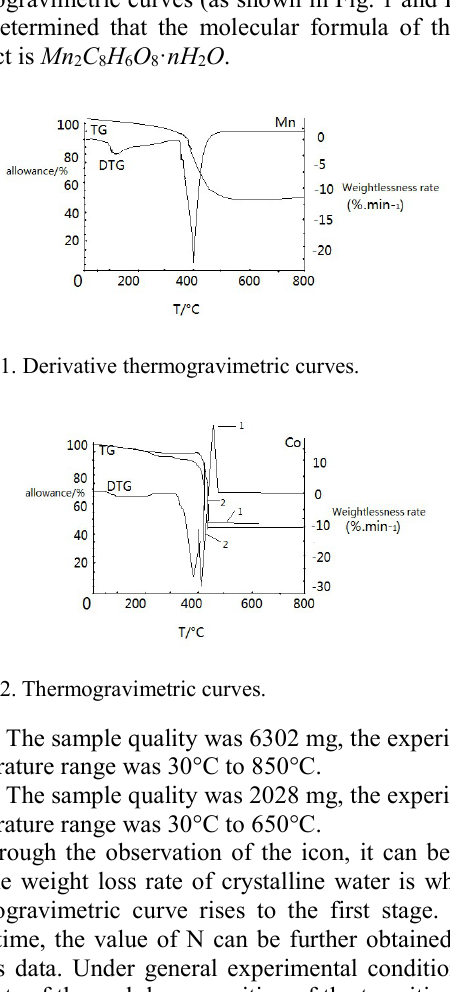
Figure 3. Infrared spectra comparison of 1,2,3,4- butane four carboxylic acid and four sodium salt and manganese complex.